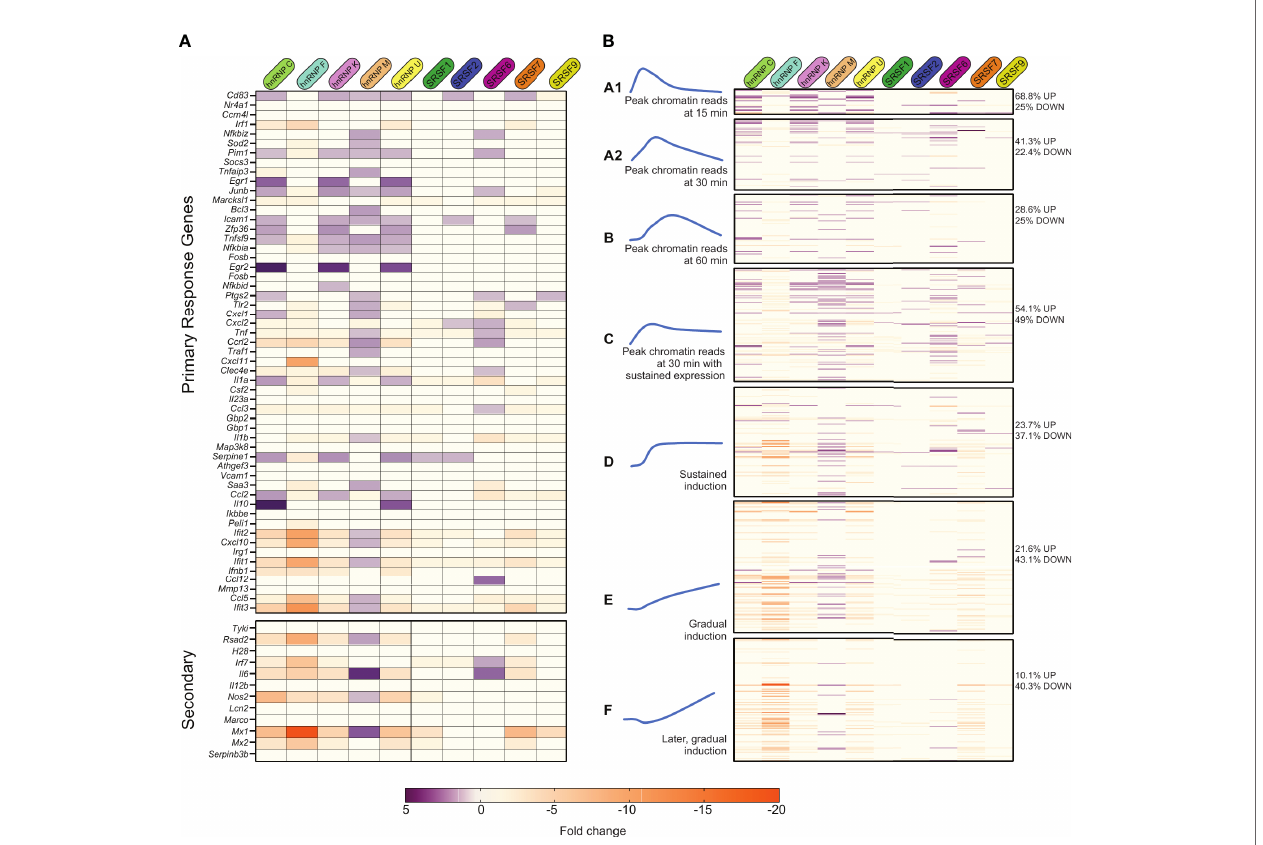
FIGURE 7 | Many primary response and early induced innate immune genes are repressed by SR/hnRNPs. (A) Fold change of SR/hnRNP DEGs in Salmonella - infected RAW 264.7 macrophages compared to SCR controls for genes categorized as primary (top) and secondary (bottom) response genes according to 10. 35/ 53 primary response genes are upregulated by loss of one or more SR/hnRNPs at 4h post- Salmonella infection. (B) Fold change of SR/hnRNP DEGs in Salmonella - infected RAW 264.7 macrophages compared to SCR controls with Lipid A-induced genes categorized on basis of induction kinetics as de fi ned by 6. Percentages on right indicate the number of genes in each category that are differentially expressed (up- or down-regulated) by loss of one or more SR/hnRNP. (left) Blue curves are schematic representations of the induction kinetics of each Group (A1, A2, B, C, D, E, and F) over a 120-minute time course following Lipid A treatment. Adapted from